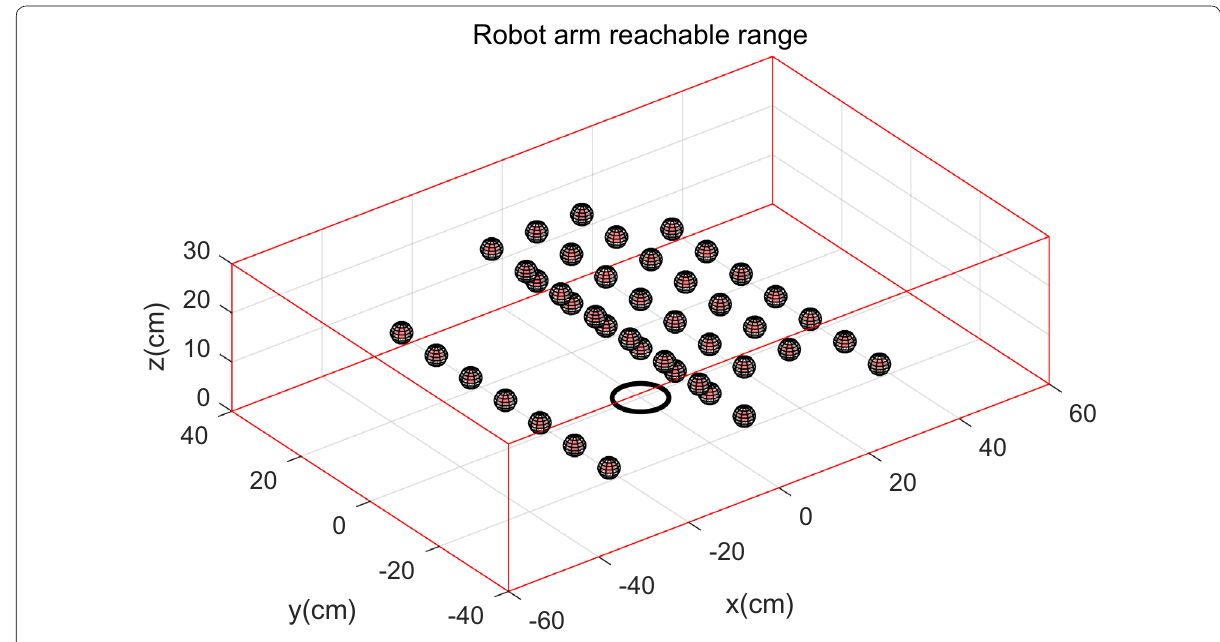
Figure 6 Working space and obstacle